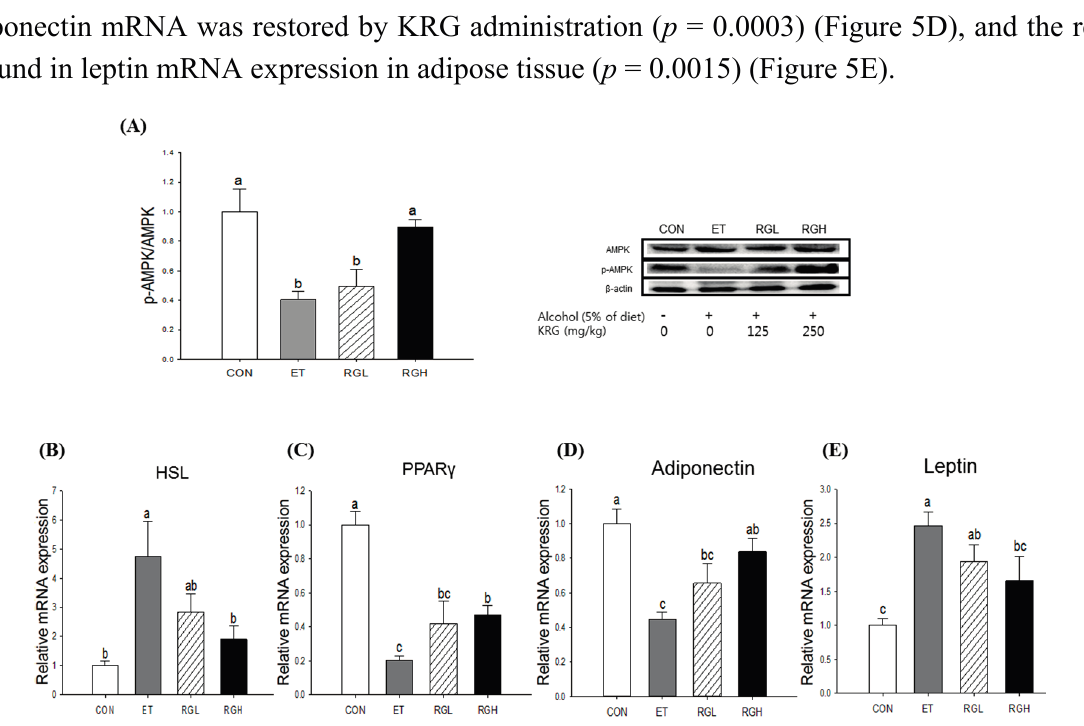
Figure 5. Protein phosphorylation and mRNA expression in adipose tissue of rats fed alcohol and KRG for 6 weeks. ( A ) AMPK phosphorylation; ( B ) HSL mRNA expression; ( C ) PPAR- γ mRNA expression; ( D ) Adiponectin mRNA expression, and ( E ) Leptin mRNA expression. CON, normal control; ET, alcohol control; RGL, alcohol + 125 mg/kg KRG; RGH,